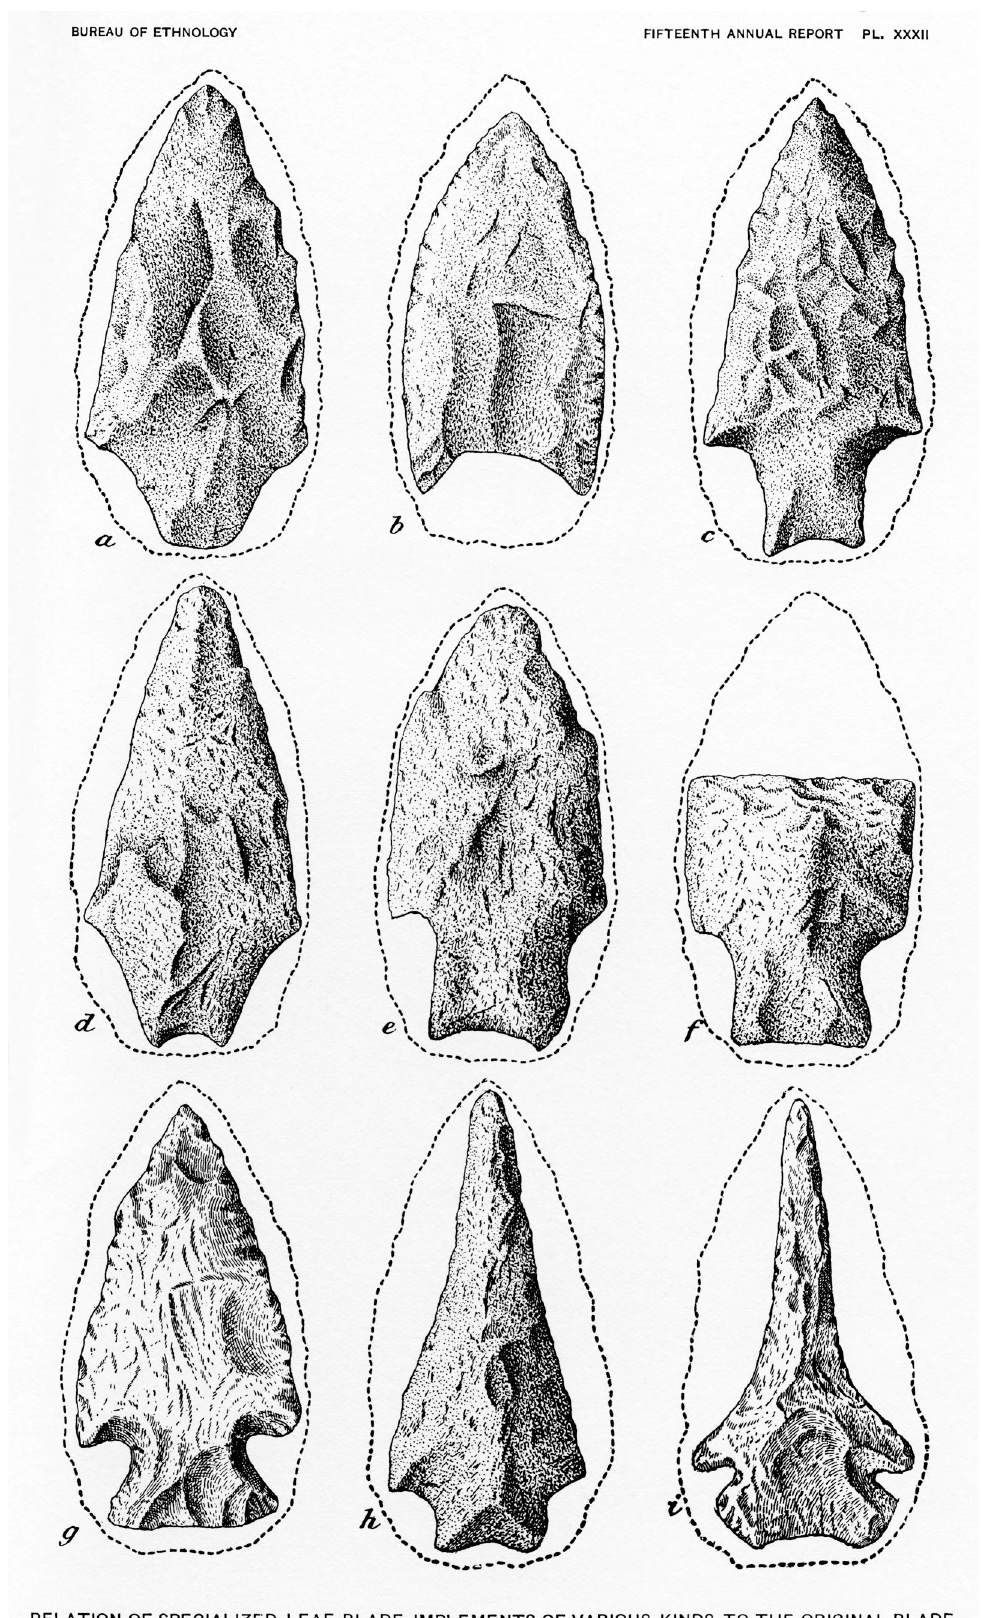
Figure 9. Bifacial projectile points knapped from Holmes’ “leaf-blades.” Note the fluted point (b), evidence that Holmes mixed materials of different dates when constructing his Progressive Series. After Holmes 1897: plate xxxii. [Original caption: Relation of specialized leaf-blade implements of various kinds to the original